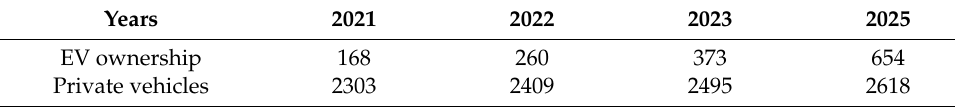
Table 2. Forecast results of the ownership of EVs in RAs.